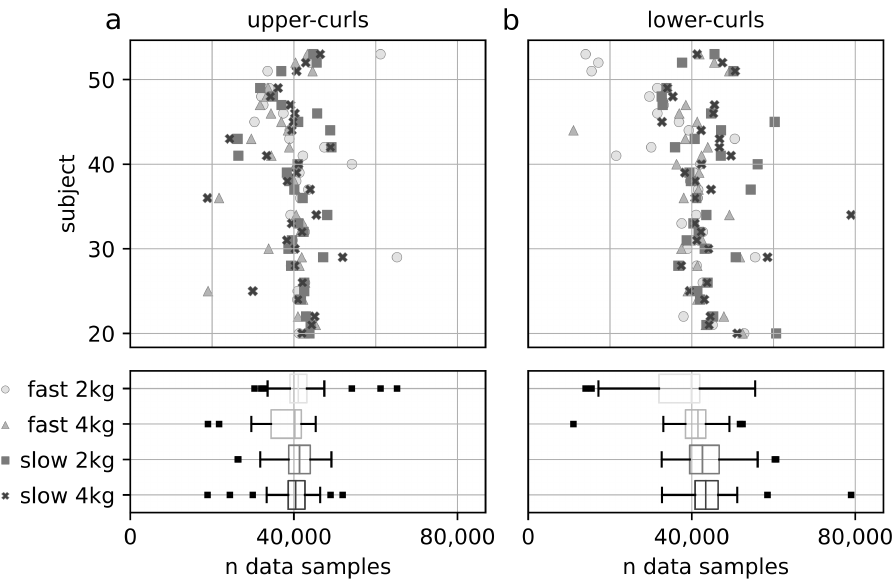
Figure 2. Distribution of the number ( n ) of recorded sEMG data samples (sampling rate of 1111 Hz) for each subject separated by posture : ( a ) upper curls and ( b ) lower curls . The plots in the top row depict the data samples per individual subject. The boxplots in the lower row summarize the distribution of data samples based on experimental conditions ( speed and load ) for all subjects. Whiskers are plotted within the 1.5 interquartile range (IQR), and black dots represent